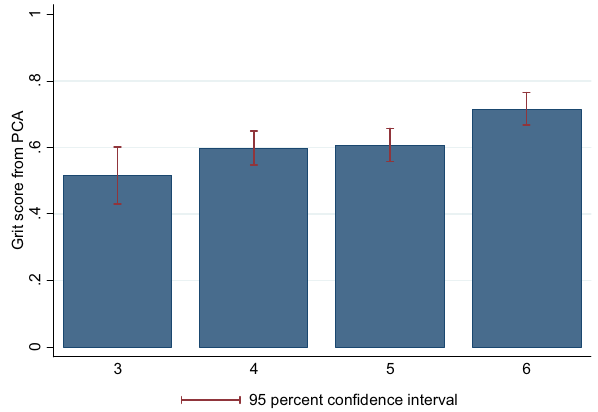
Figure 2. Grit score by age. Notes: The figure shows for each age cohort (on horizontal axis) the grit score from the principal component analysis (taking into account whether the difficult puzzle had been chosen, whether that puzzle had been completed, and whether a child performed above median in the perseverance task in its age